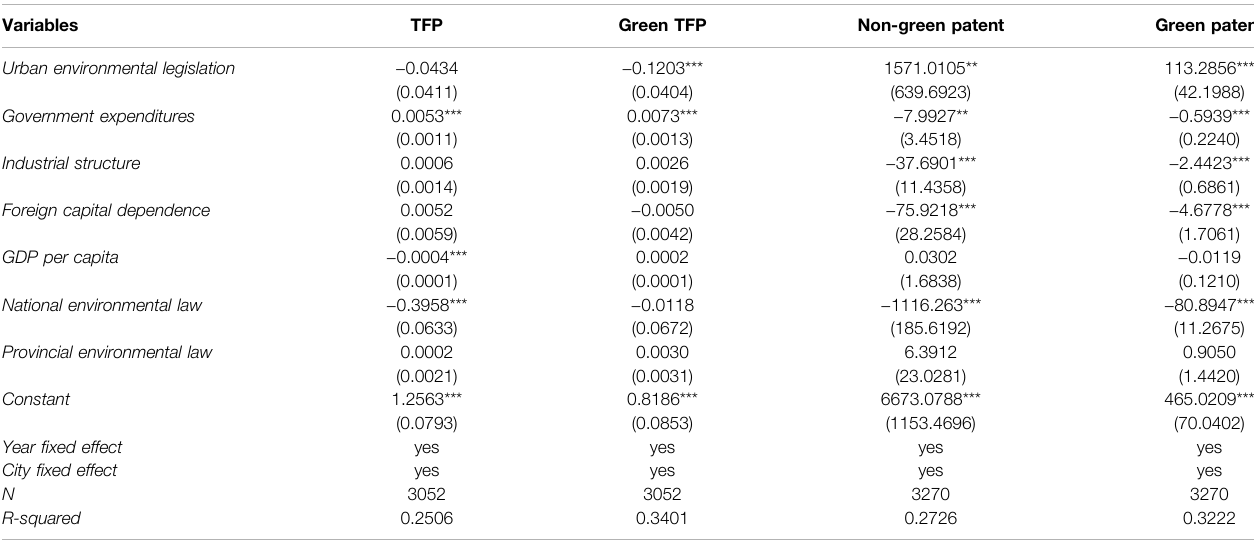
TABLE 3 | Results of benchmark regression.